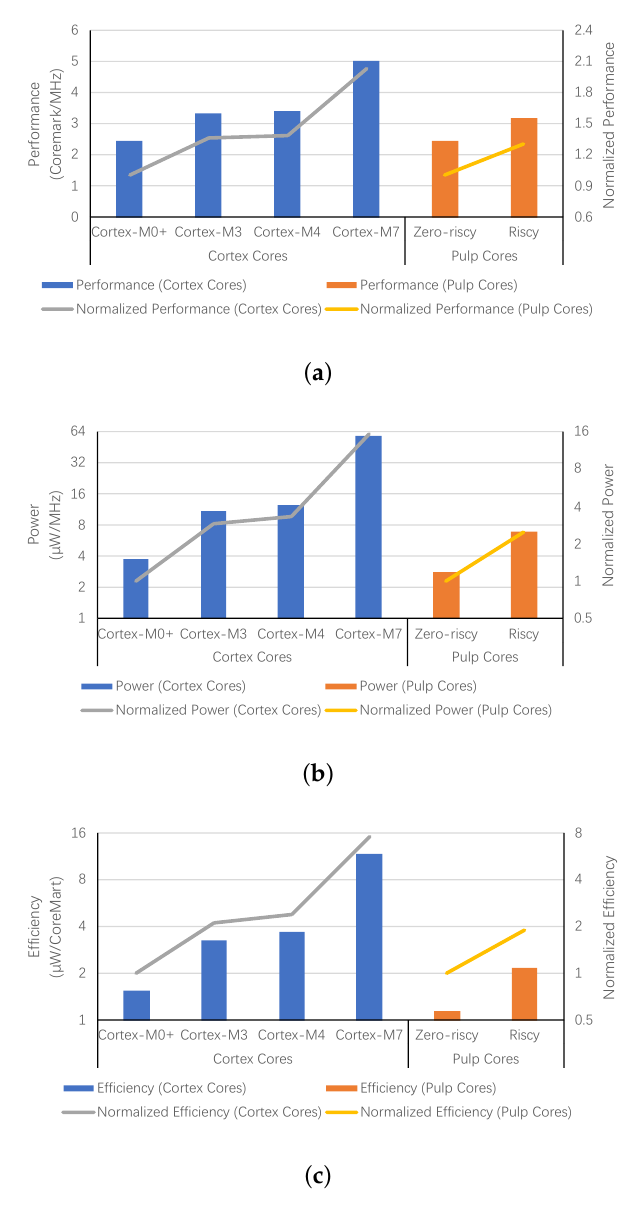
Figure 1. Performance, power and energy efficiency of Cortex-M cores and Pulp cores. ( a ) Perfor- mance of Cortex-M Cores and Pulp Cores, ( b ) Power of Cortex-M Cores and Pulp Cores, ( c ) Energy Efficiency of Cortex-M Cores and Pulp